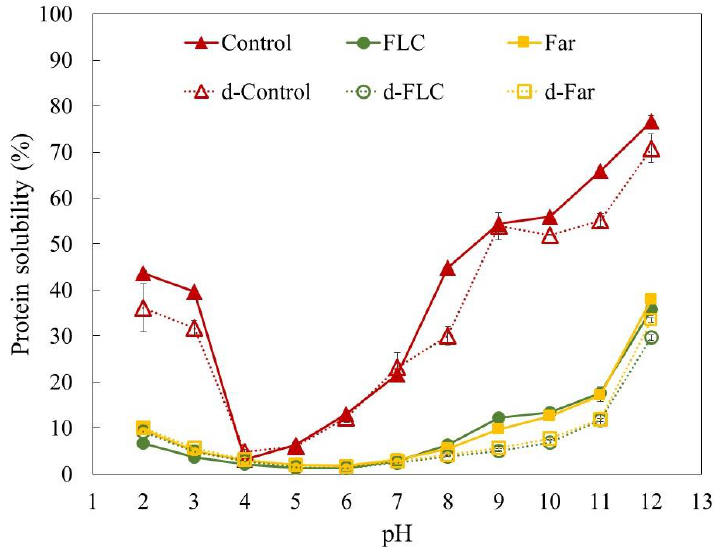
Figure 4. Protein solubility of the full fat (Control and the fermented samples FLC and FAR) and defatted (d-Control and the fermented samples d-FLC and d-Far) mealworm powders as a function